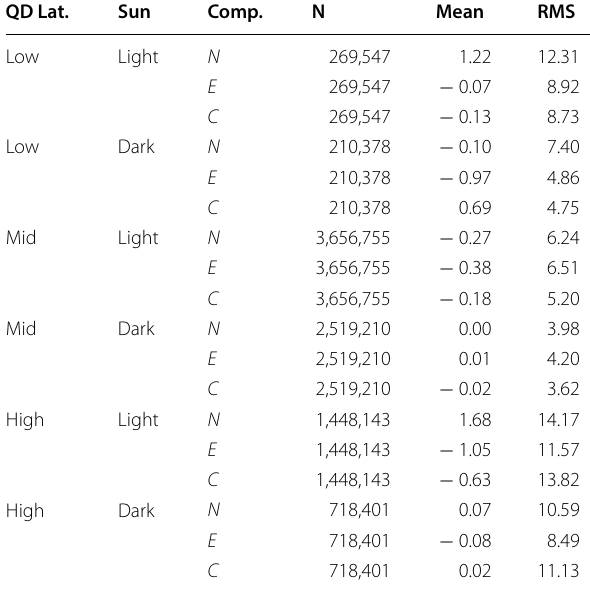
Mean and RMS are in units of “nT”